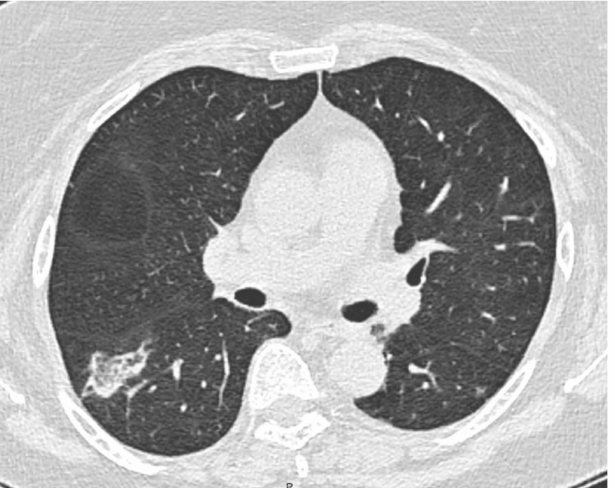
Figure 1. CT scan showing right lower lobe